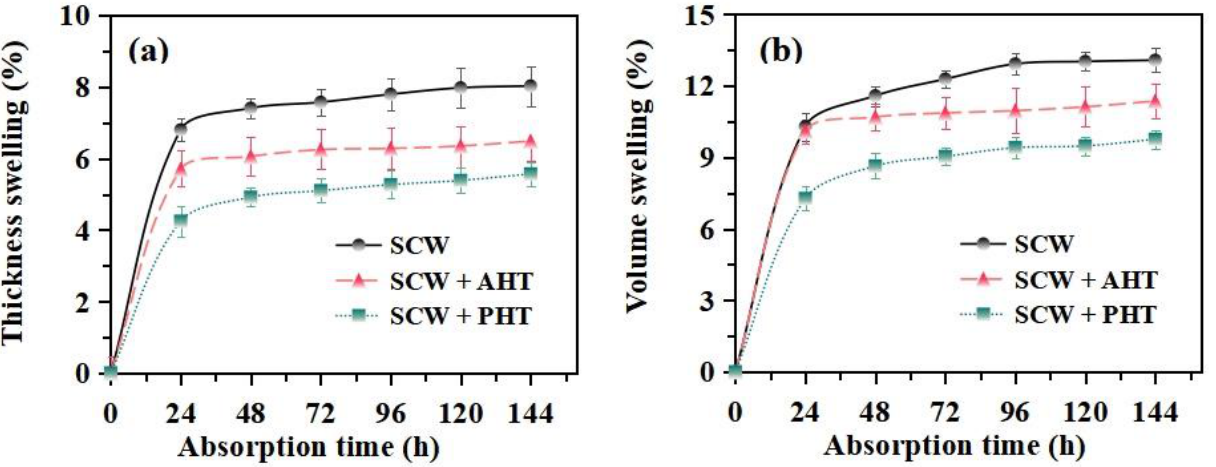
Figure 1. Moisture absorption-induced swelling of SCW, SCW + AHT, and SCW + PHT. ( a ) Thick- ness swelling and ( b ) volume swelling. SCW, surface-compressed wood without post-treatment; SCW + AHT, surface-compressed wood with atmospheric steam heat treatment; SCW + PHT, sur- face-compressed wood with pressurized steam heat treatment.